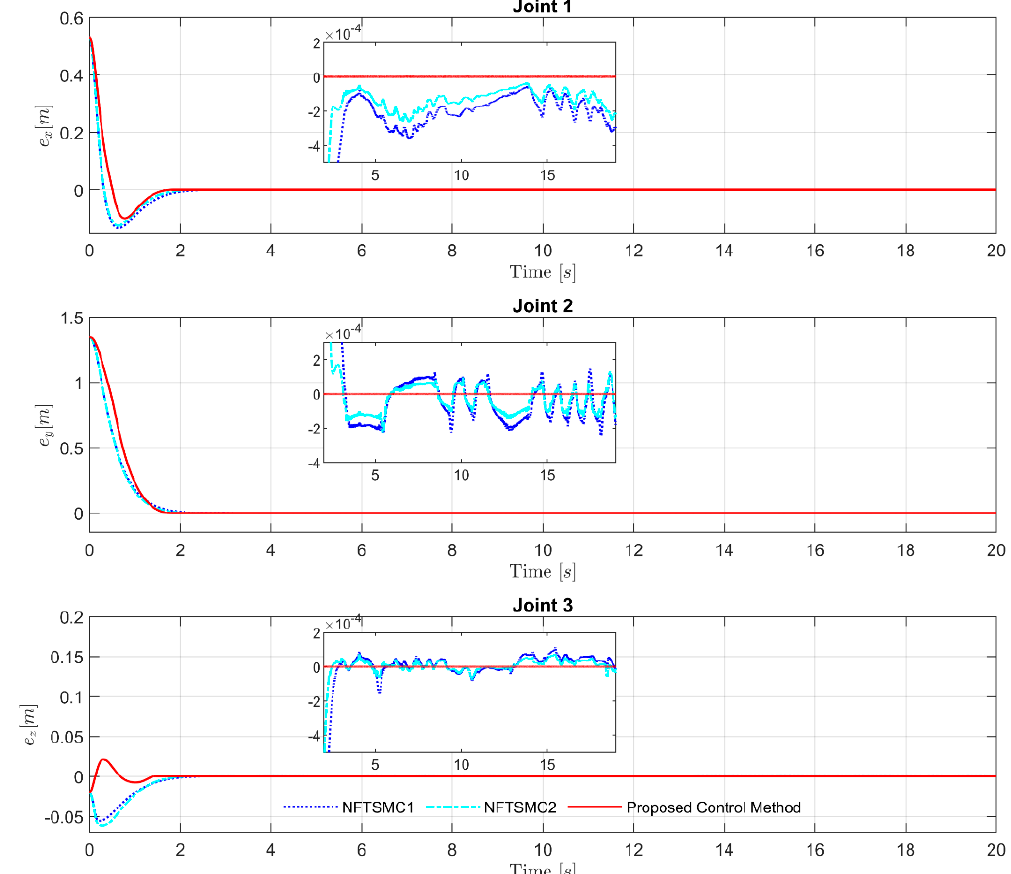
Figure 6. Path of the control errors in 3-dimensional space (XYZ).